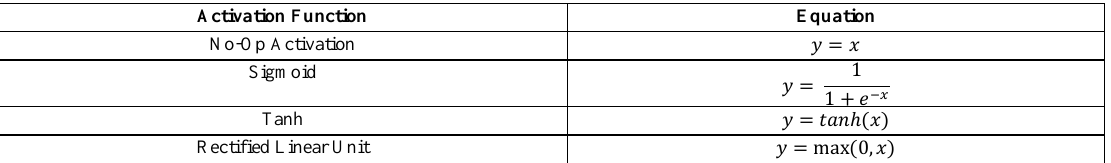
Table 3. Activation